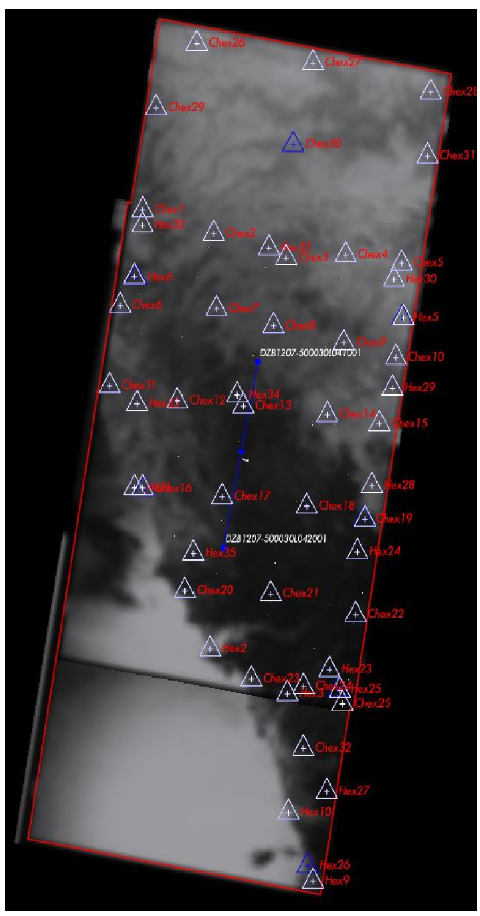
Figure 2. KH9 Hexagon stereo pair with GCPs